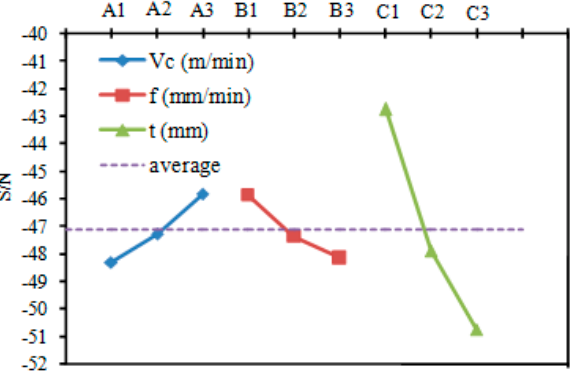
Figure 6. S/N ratios of control parameters at room temperature.